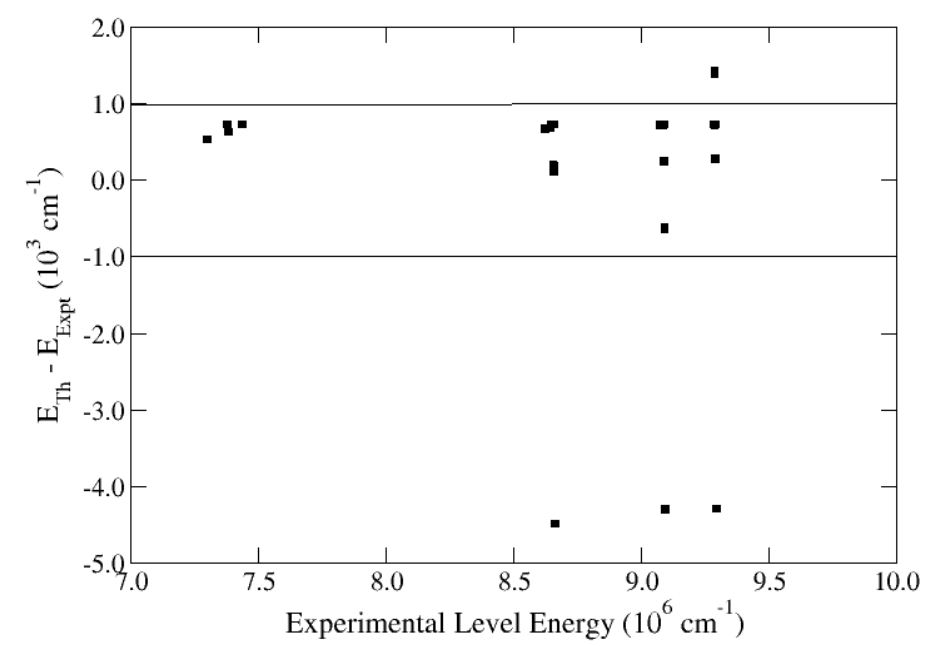
Figure 5. Level energy differences in Ne IX between the theoretical values of [121] and the experimental data listed in the NIST database (v5.1). Such differences are mostly bound to the interval ± 1000 cm − 1 except for six levels whose spectroscopic positions are open for a